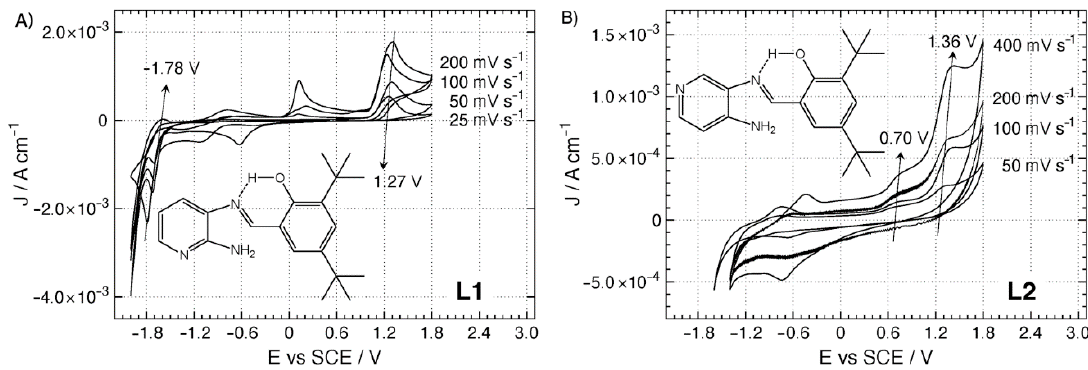
Figure 3. Scan-rate study for L1 and L2 . Interphase: Pt | 1.0 10 − 2 M of compound + 1.0 × 10 − 1 M TBAPF 6 in anhydrous CH 3 CN.